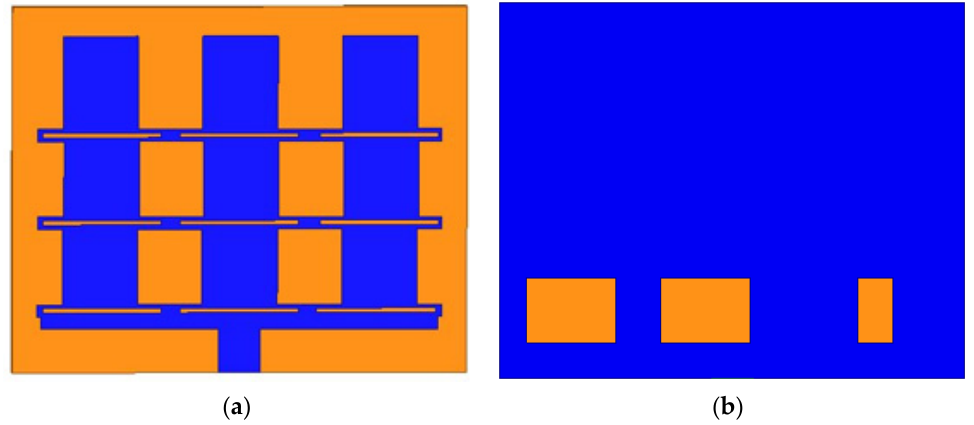
( b ) Figure 2. ( a ). Top view of the antenna (M ) showing the patch array structure of the antenna, ( b ) bottom view of the antenna showing the full ground plane.